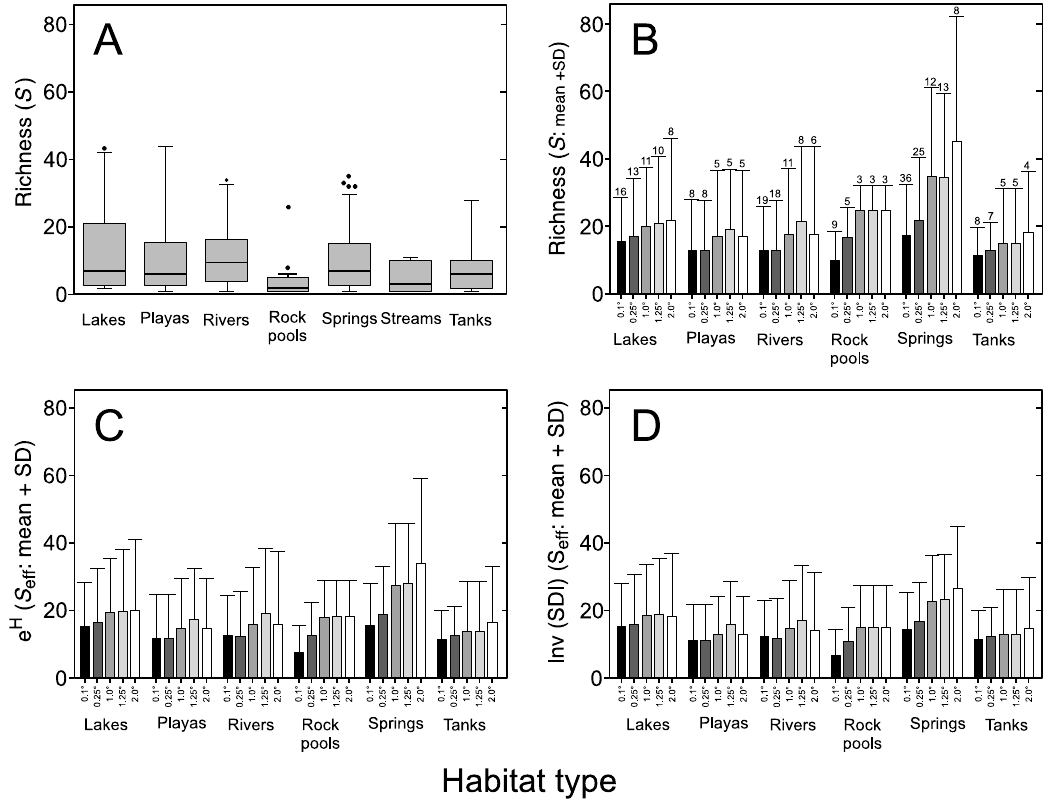
Figure 1. Observed species richness ( S ) of rotifers in 236 Chihuahuan Desert aquatic sites grouped by habitat type over > 20 years. ( A ) Boxplots: horizontal lines indicate median, 95% confidence intervals are shown; dots represent outliers, ( B ) Richness at di ff erent geographic scales (grid cell sizes: 0.1 ◦ , 0.25 ◦ , 1.0 ◦ , 1.25 ◦ , 2.0 ◦ ), numbers above bars are sample sizes, and are the same for panels C and D. ( C ) E ff ective richness e H ; Hill number, order q = 1. ( D ) E ff ective richness based on inverse (inv) of the Simpson’s Diversity Index (SDI); Hill number, order q = 2. Table 1. Species richness, unique species, and Sorensen’s Index (below diagonal) and number of shared species (above diagonal) of rotifers from five selected habitat types in the Chihuahuan